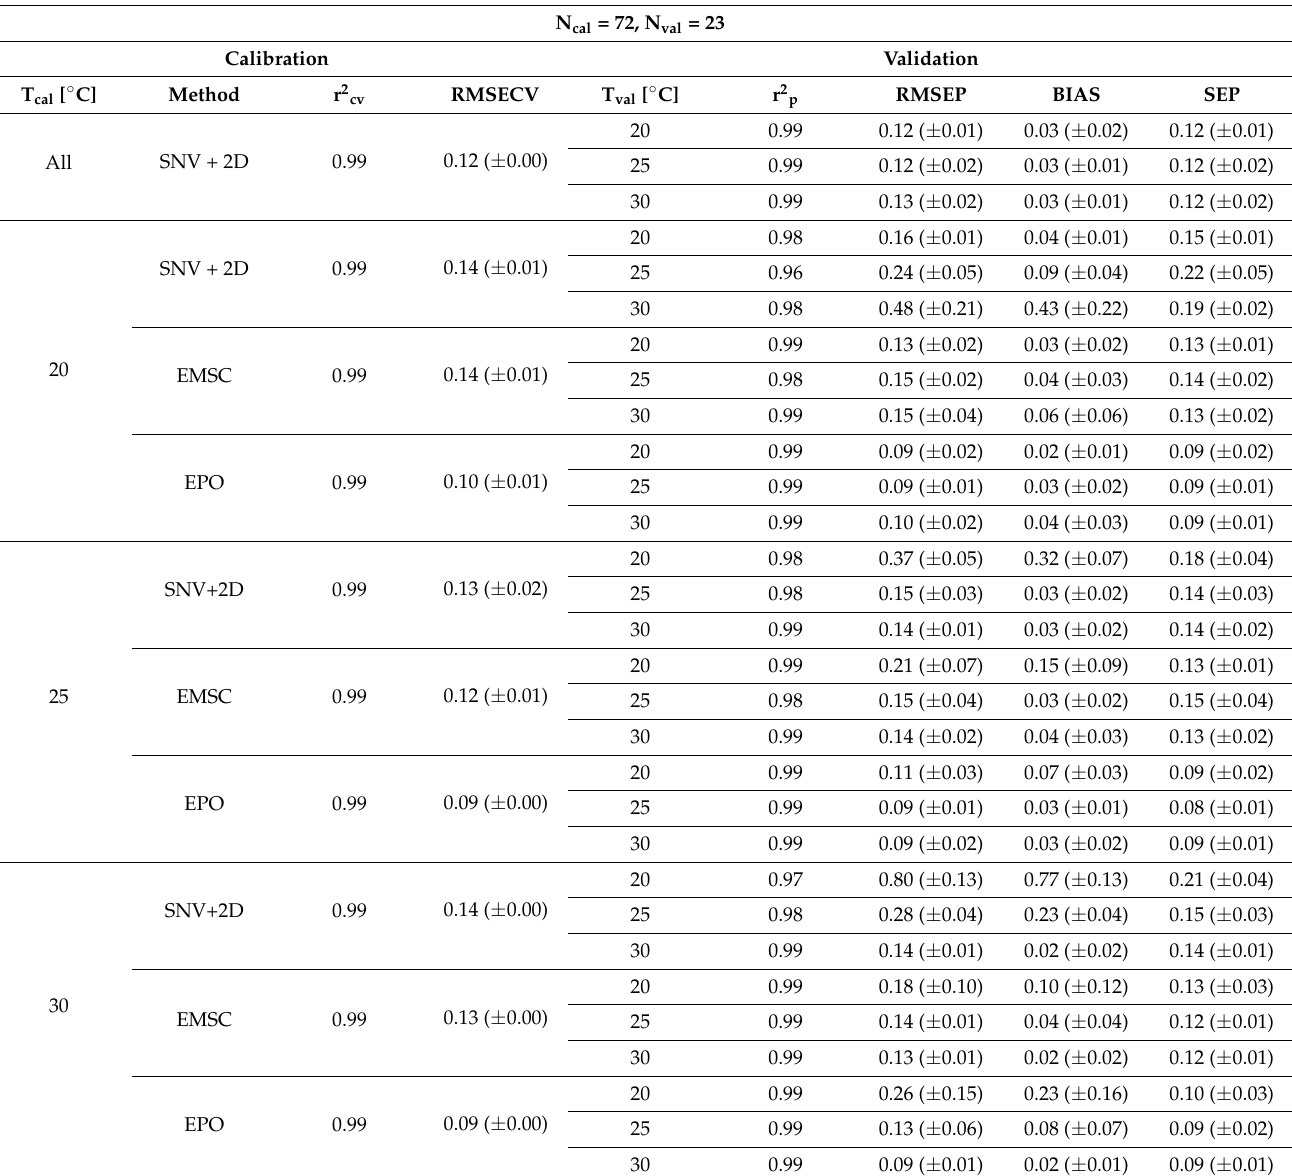
Table 2. Performance comparison for soluble solids content (SSC) prediction of kiwifruit juice in the first overtone (1300–1600 nm) region of the OH stretch of water at different